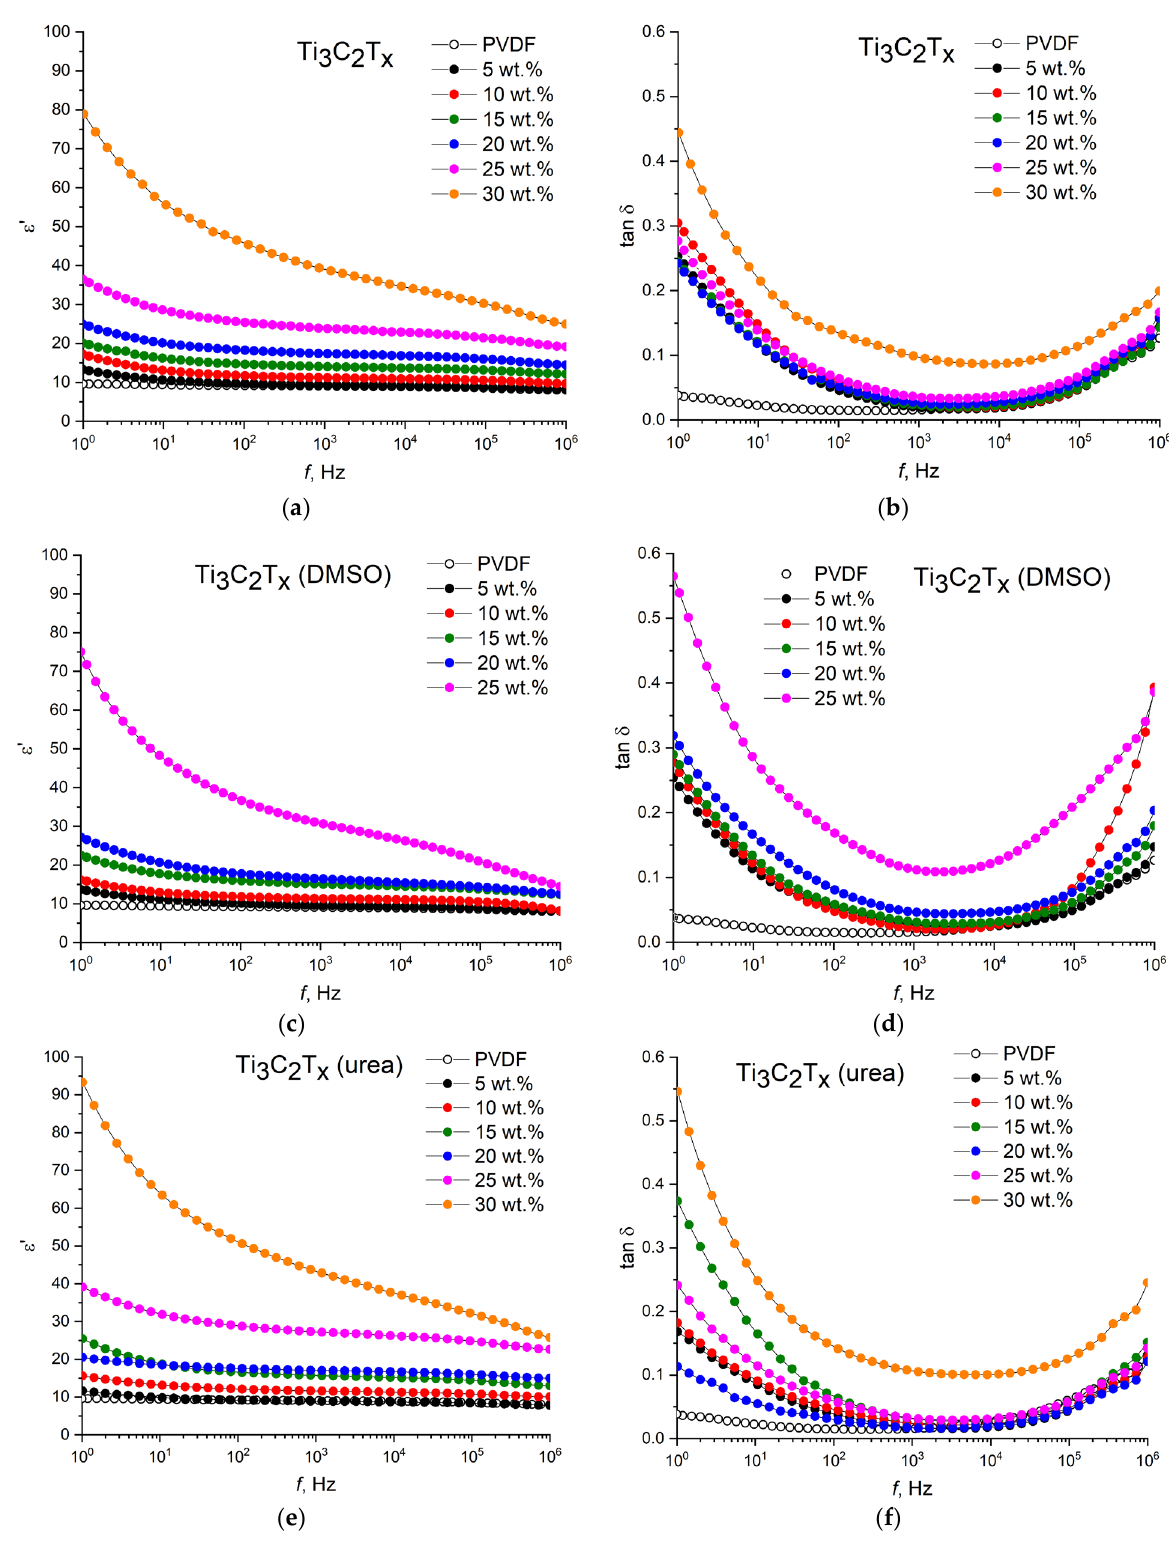
Figure 5. Frequency dependences of permittivity of ( a ) PVDF/Ti 3 C 2 T x , ( c ) PVDF/Ti 3 C 2 T x (DMSO), and ( e ) PVDF/Ti 3 C 2 T x (urea) and dielectric loss of ( b ) PVDF/Ti 3 C 2 T x , ( d ) PVDF/Ti 3 C 2 T x (DMSO), and ( f ) PVDF/Ti 3 C 2 T x (urea).